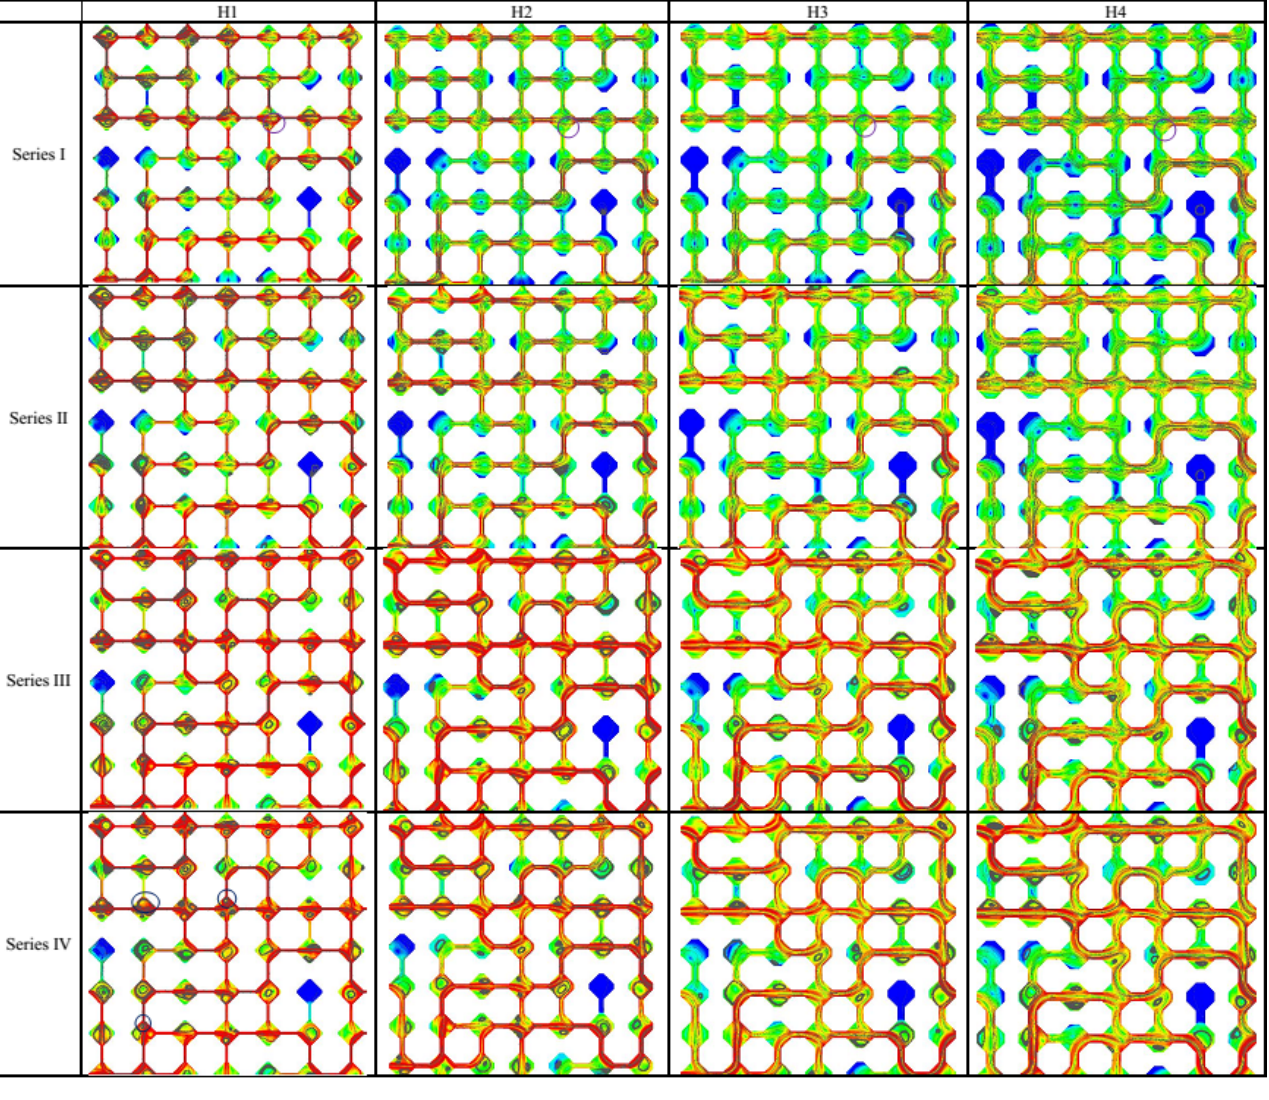
Figure 6. Contours of dissipation along with streamlines for various geometries at the conditions that are marked in Figure